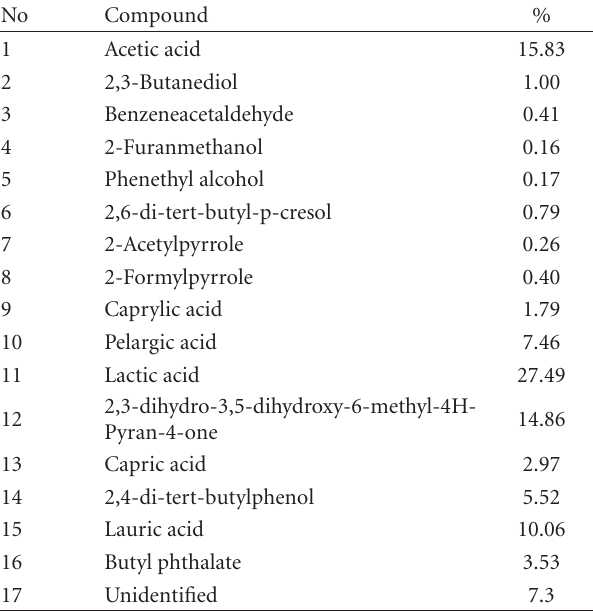
Table 2: Composition of volatile compounds from solid Agave salmiana , obtained from the PEG fiber and Stabilwax column (carbowax).